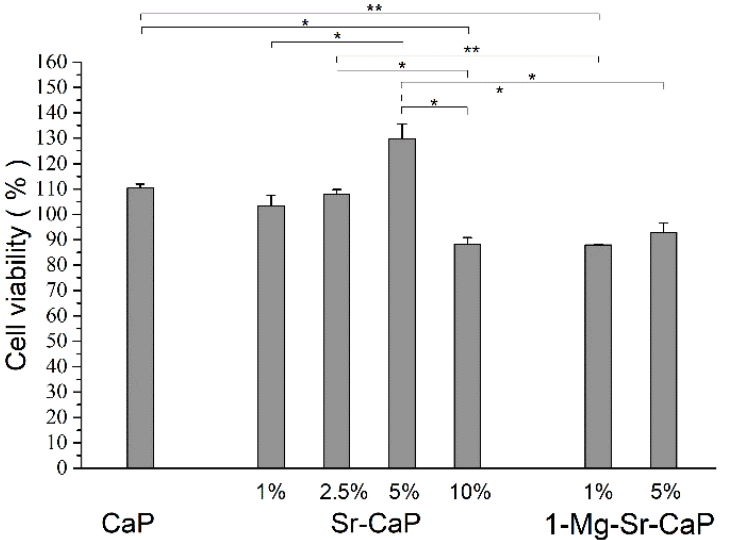
Figure 4. MTT assay of Hek293 human embryonic kidney cell line cultured in extracts of CaP, Sr-CaP and Mg-Sr-CaP samples for 72 h. Extracts were obtained after soaking the samples into the culture medium for 7 days. Data are expressed as a percentage over the control cells, considering the control group as 100% (untreated cells). The significant difference between two groups: * p < 0.05; ** p < 0.01. Estimated cells viability (between 85% and 130% of control) indicates that all studied scaffolds do not release toxic substances and do not show a negative effect on cell